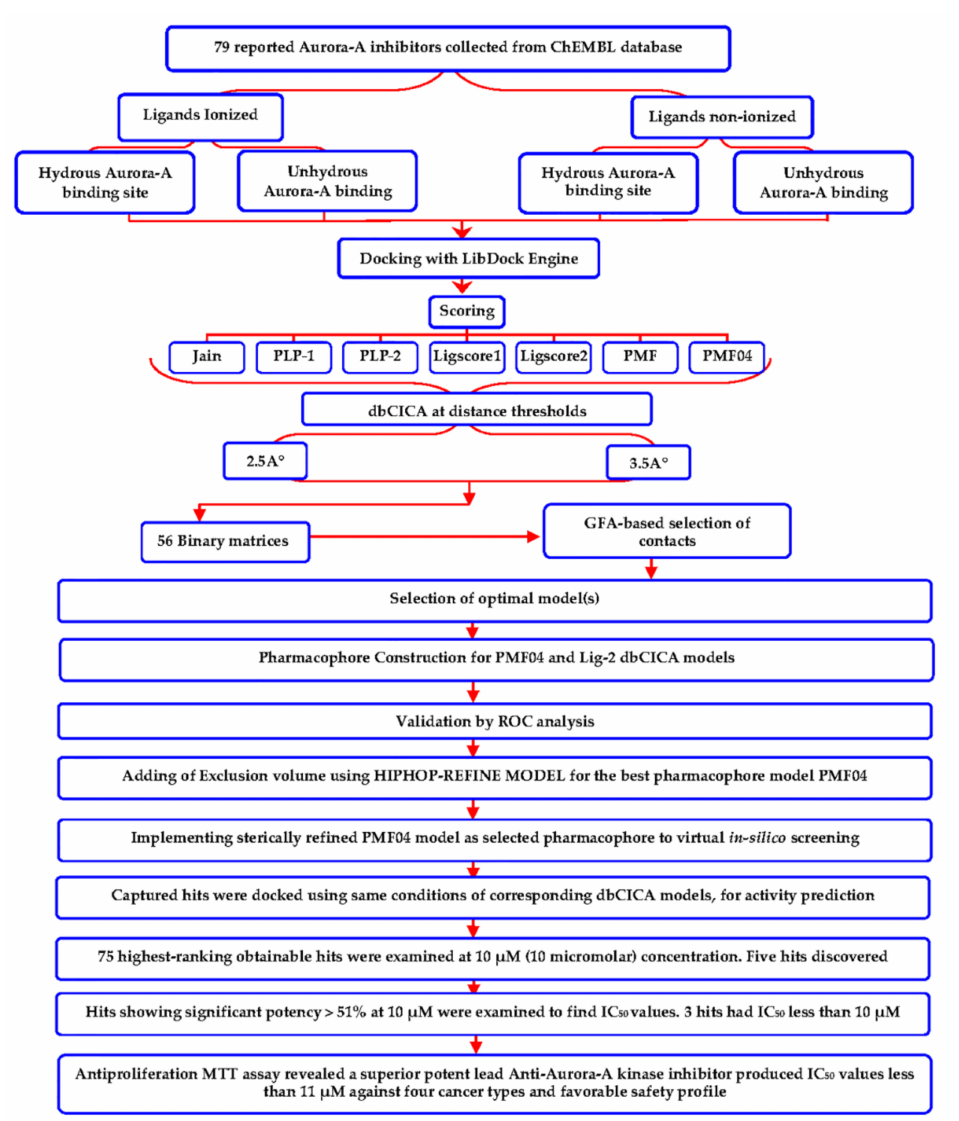
Figure 7. Summary for adopted structure-based modeling and biological evaluation